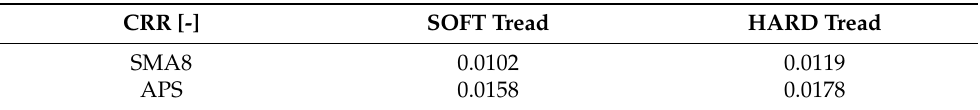
Figure 15. Comparison of Coefficients of Rolling Resistance measured by road method on SMA8 pavement and by drum method on SMA8 replica. Table 3. Coefficients of Rolling Resistance of SOFT and HARD slick tires tested according to ISO standard on replicas SMA8 and APS at 80 km/h.